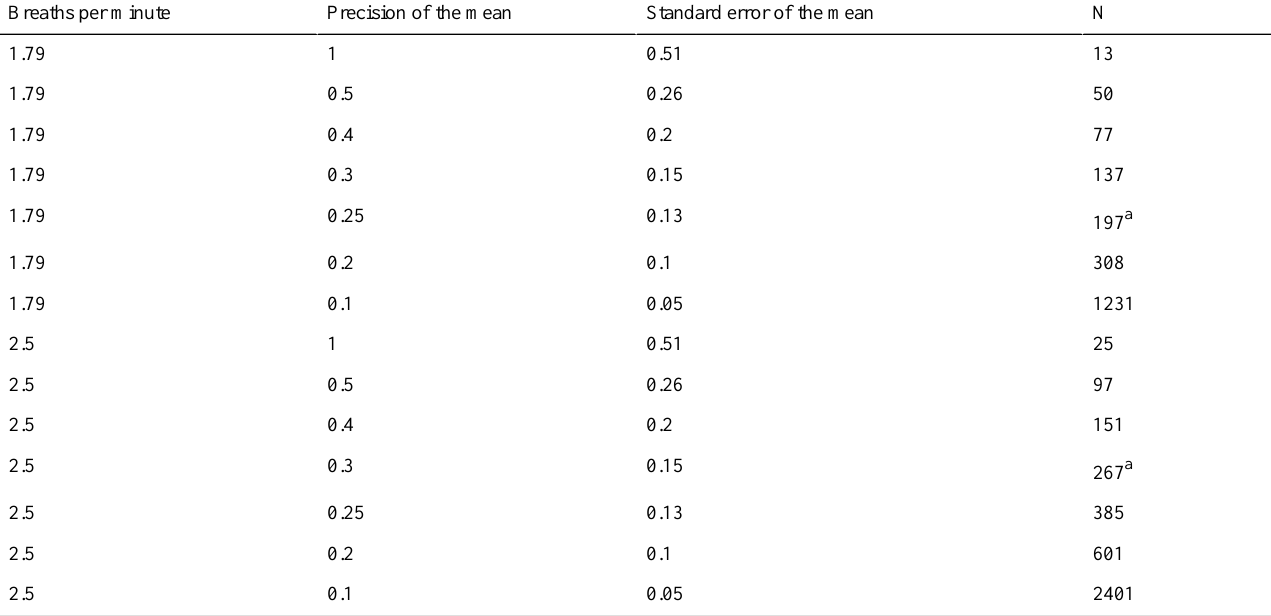
Table 3. Precision of mean at 95% confidence interval.